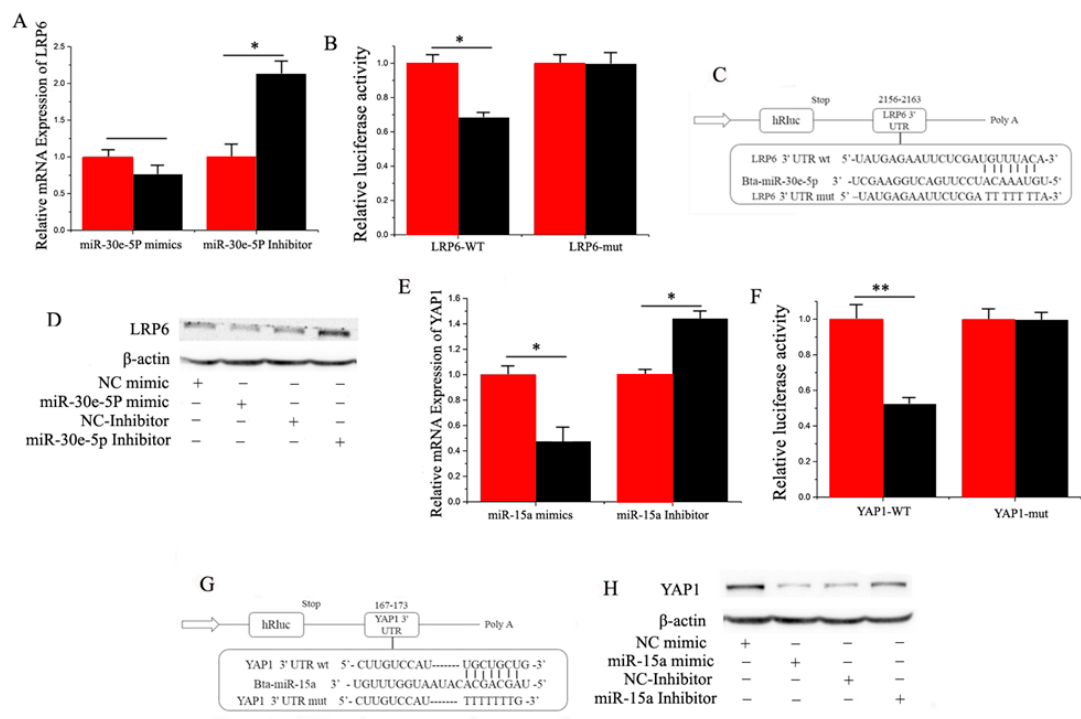
Figure 3. ( A ) RT-qPCR quantification of the LRP6 expression ( n = 6). Red bars represent the negative control; black bars represent miR-30e-5p mimic or inhibitor; ( B , C ) Target site of miR-30e-5p in LRP6 3 ′ -UTR and the construction of the luciferase (Luc) expression vector fused with the LRP6 3 ′ -UTR. WT represents the Luc reporter vector with the WT LRP6 3 ′ -UTR (2155–2163); MU represents the Luc reporter vector with the mutation at the miR-30e-5p site in LRP6 3 ′ -UTR; ( D ) The effect of miR-30e-5p mimicking and inhibiting LRP6 protein expression was evaluated by Western blot analysis in GMEC; ( E ) The YAP1 expression level was quantified by RT-qPCR ( n = 6). Red bars represent the negative control; black bars represent miR-15a mimic or inhibitor; ( F , G ) Target site of miR-15a in the YAP1 3 ′ -UTR and the construction of the luciferase (Luc) expression vector fused with the YAP1 3 ′ -UTR. WT represents the Luc reporter vector with the WT YAP1 3 ′ -UTR (167–173); MU represents the Luc reporter vector with the mutation at the miR-15a site in YAP1 3 ′ -UTR; ( H ) The effect of miR-15a mimicking and inhibiting YAP1 protein expression was evaluated by Western blot analysis in GMEC. All experiments were duplicated and repeated three times. Values are presented as means ± standard errors, * p < 0.05; ** p < 0.01.